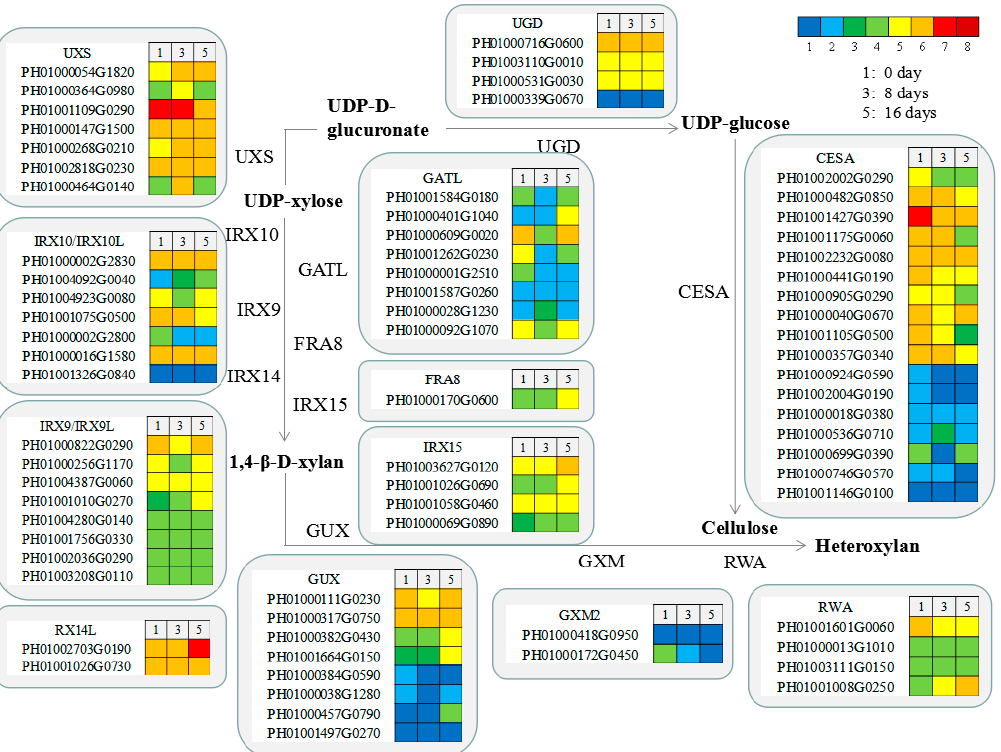
Figure 6. Genes involved in cellulose and xylan biosynthesis in different periods of cold storage of MBSes. Enzyme names, unigene IDs, and expression patterns are indicated in each step. The grids with eight different colors from blue to red show the reads per kilobase per million reads (RPKM) values. Here, 0-1, 1-3, 3-5, 5-10, 10-20, 20-30, 30-50, and over 50 are represented by colors 1 to 8, respectively.